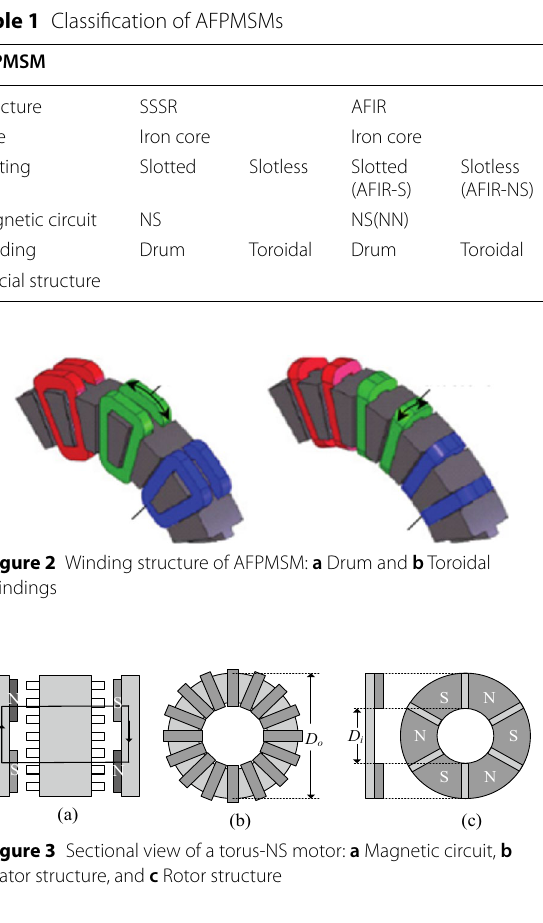
Figure 1 Organization of the paper